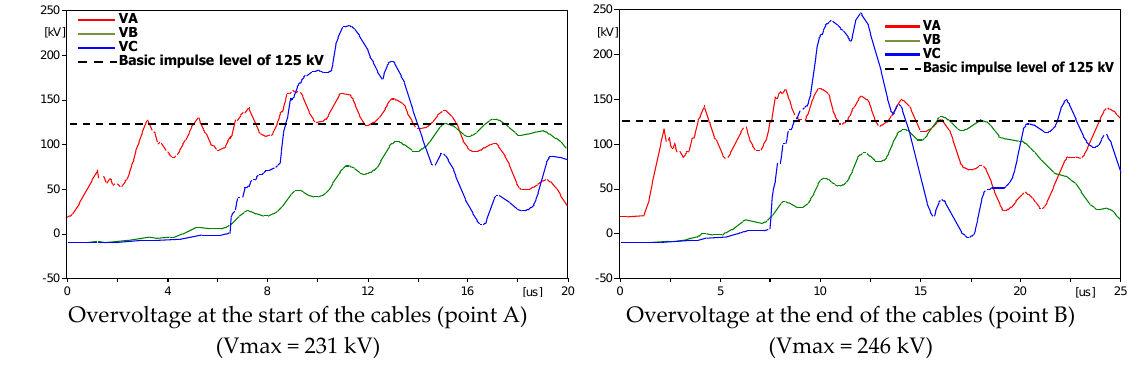
Figure 28. A 100 m underground cable.